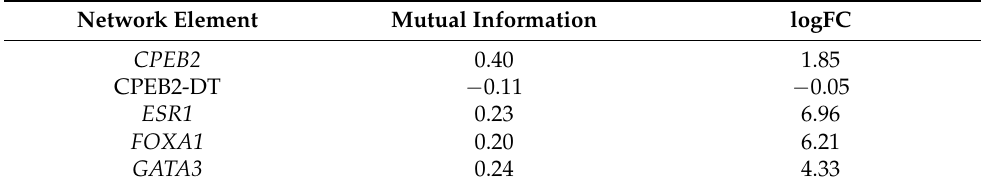
Figure 5. Functional validations of LINC00504 in luminal A cell lines. ( A ) LINC00504 silencing efficiency 48 h after transfection; ( B ) Cell viability in MCF-7 cell line; ( C ) Cell viability in ZR75-1 cell line; ( D ) Colony formation in MCF-7 and ( E ) Colony formation in ZR75-1 cell line; *** p < 0.01, ** p < 0.05. Table 1. LINC00504 co-expression network elements